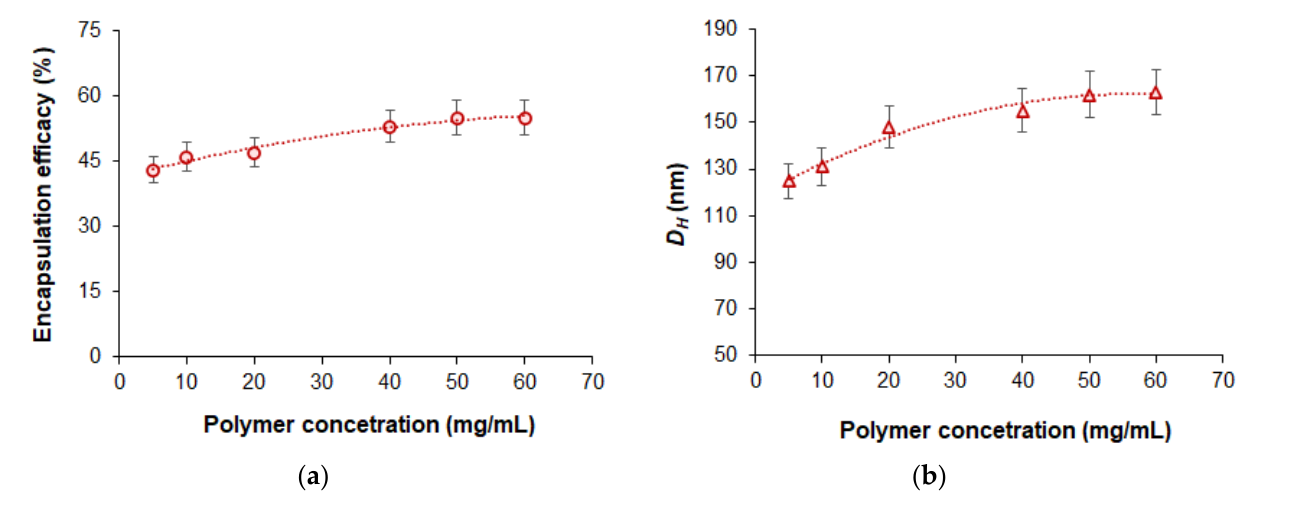
Figure 8. Effect of polymer concentration in organic phase on the encapsulation efficacy ( a ) and hydrodynamic diameter ( b ) of the dioxadet delivery systems based on mPEG- b -PCL ( M w = 29,200). The dioxadet/polymer ratio was kept constant at 250 µ g/mg of polymer.